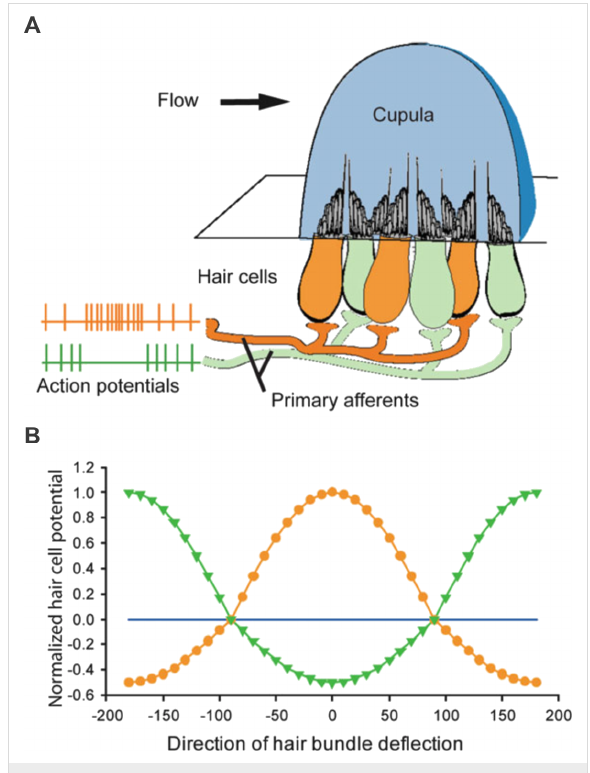
Figure 1: Opponent organization of lateral line neuromasts. (A) Hair cells on any given neuromast are oriented in one of two opposing (orange and green) directions, resulting in a single axis of best sensi- tivity. Modified with permission from [13], copyright 2004 John Wiley and Sons. (B) Hair cell responsiveness, modeled as a cosine function of the direction of hair bundle deflection for the two oppositely oriented populations of hair cells. Reproduced with permission from [14], copy- right 2014 Springer Nature.